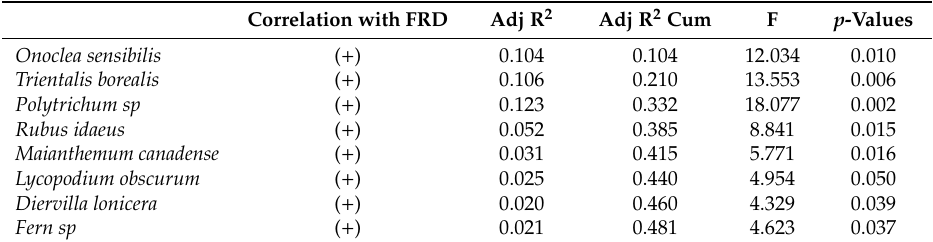
Figure 2. Venn diagram displaying the results of unique, shared, and total variation of the fine root decomposition explained by ( A ) the three silvicultural treatments and over- and understory vegetation percent cover, ( B ) understory vegetation composition. Table 2. Understory vegetation species (abundances) that best explained fine root decomposition (FRD), according to a forward selection of explanatory variables. The ( + ) sign represents a positive relationship between the abundance of the species and